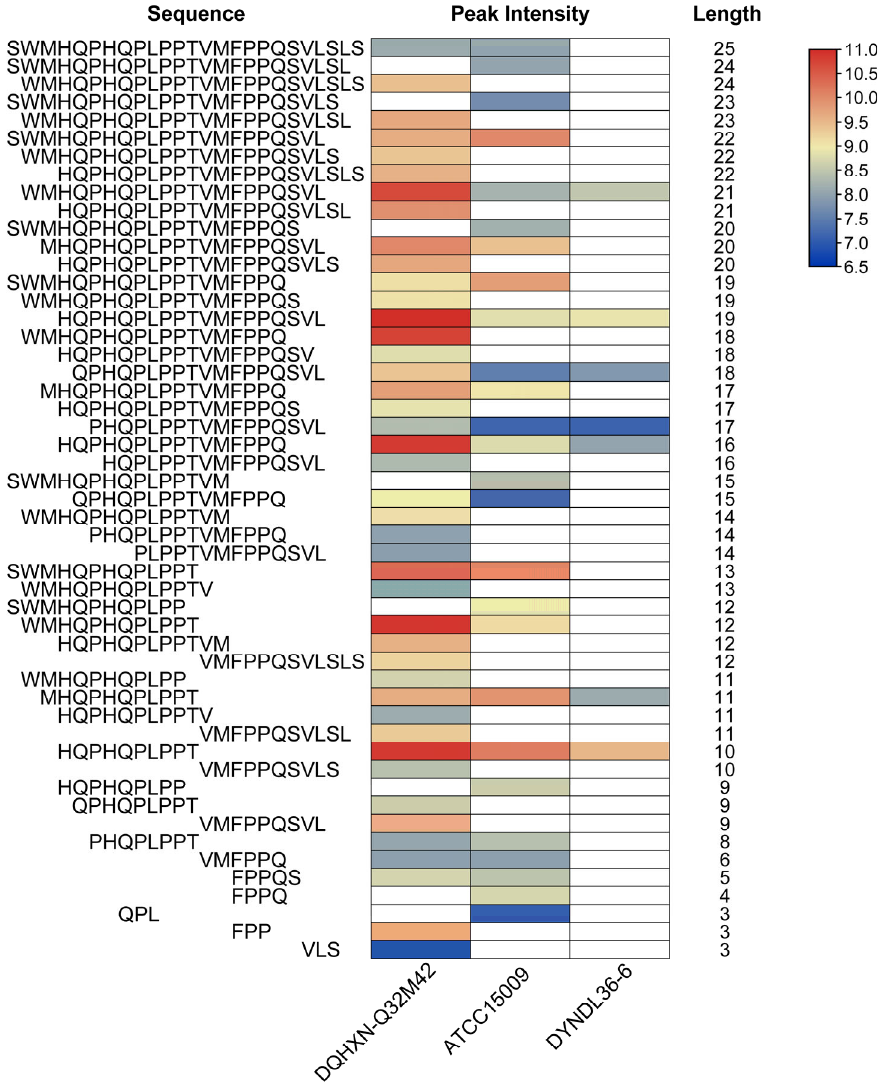
Figure 4. Heat map of peptides derived from β‐ casein (142–166).